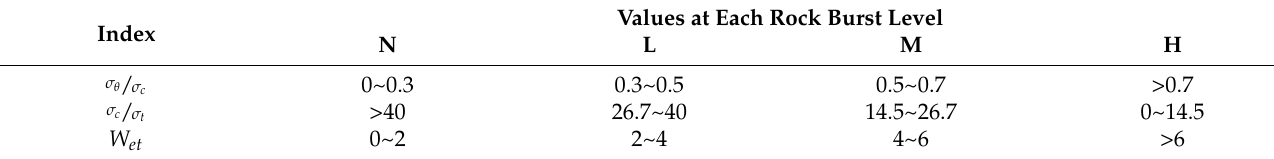
Table 1. Prediction standard of rock burst